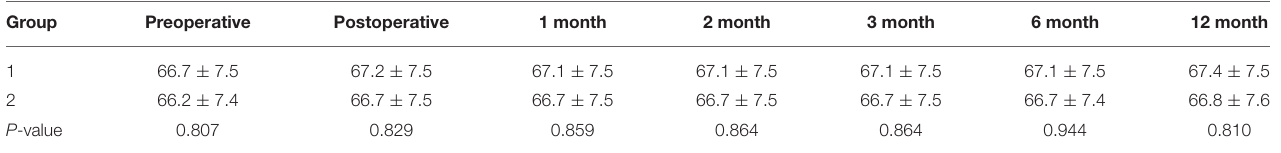
TABLE 4 | Anterior vertebral body height of the two groups (mm).